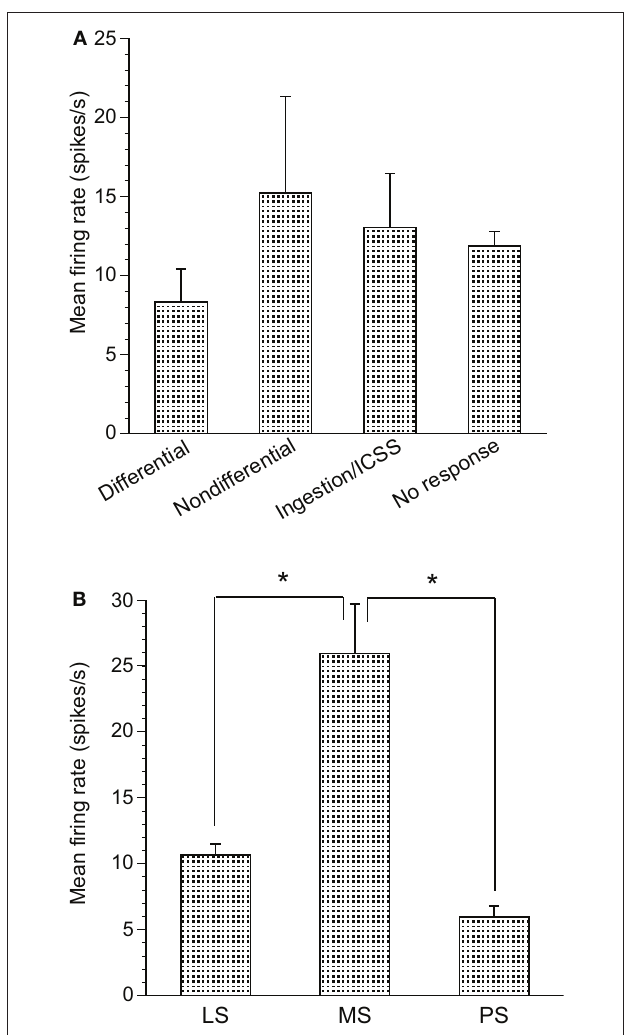
Figure 8 | Mean firing rates of neurons recorded in the septal nuclei. (A) The mean spontaneous firing rates ( ± SEM) of differential conditioned stimulus (CS)-related, non-differential CS-related, ingestion/intracranial self-stimulation (ICSS)-related and non-responsive neurons. No significant differences in mean spontaneous firing rates were found among the three groups (one-way ANOVA, p > 0.05). (B) The mean spontaneous firing rates ( ± SEM) of the lateral septal nucleus (LS), medial septal nucleus (MS), and posterior septal nucleus (PS) neurons. *significant difference in mean spontaneous firing rates (new multiple range test after a one-way ANOVA, p